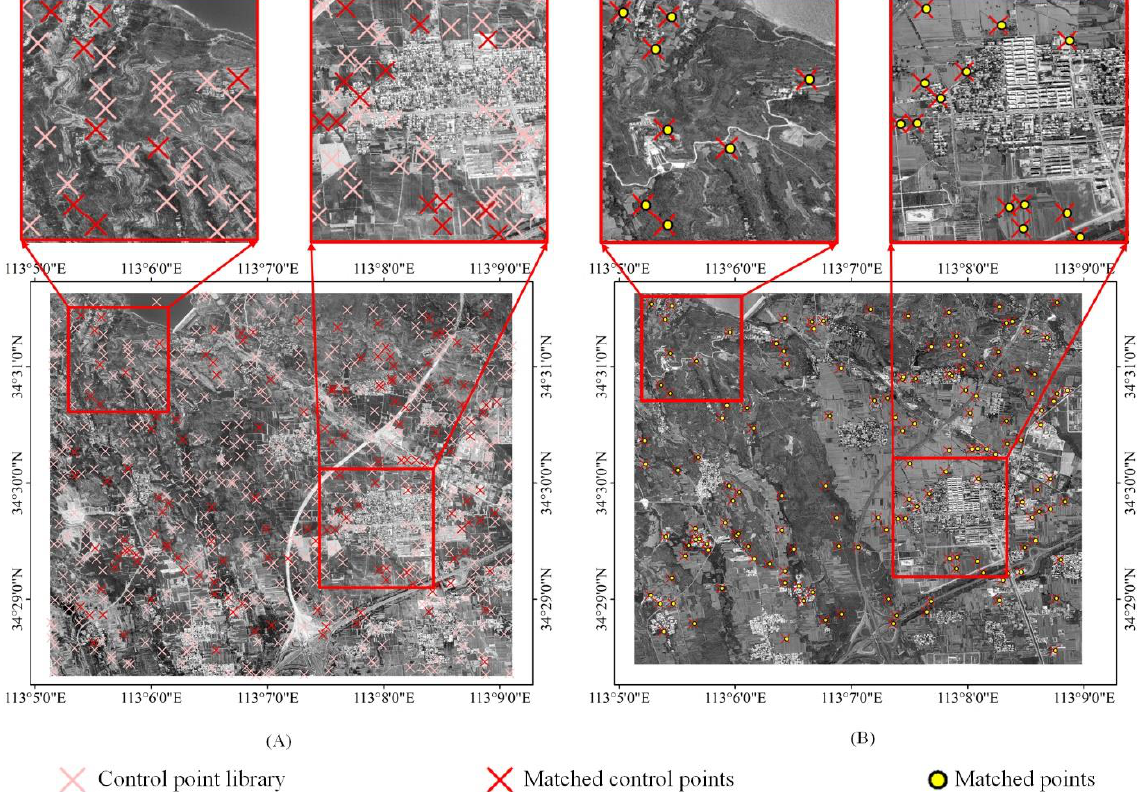
Figure 6. The results of Arcgis image matching. (A) is the GCPs image, and (B) is the Arcgis image with (163m, 152m)